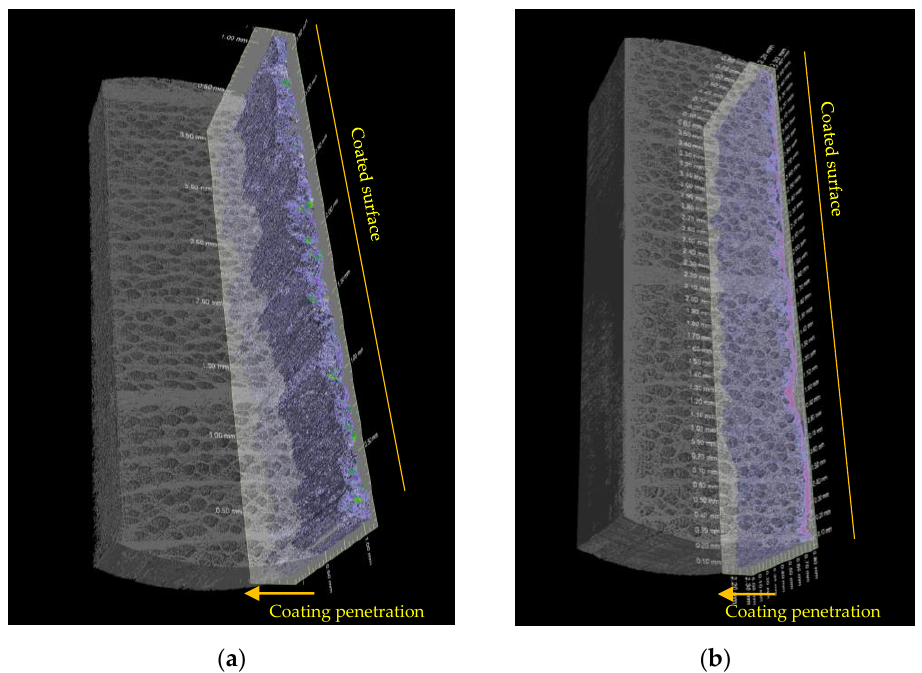
Figure 14. SL-coated veneer; ( a ) 3D visualization result using Cu target; ( b ) 3D visualization result using Mo target with Al filter.